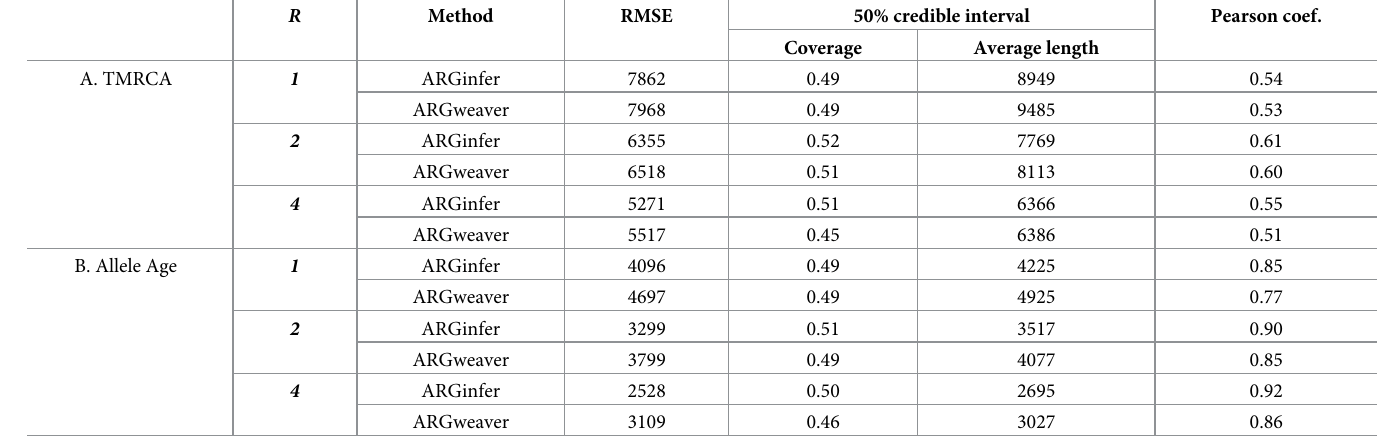
Table 3. The root mean square error (RMSE), coverage and average length of the posterior 50% equal-tailed intervals, for two ARG properties inferred by ARGinfer and ARGweaver . The ESS (reported in Table 2) is not available from ARGweaver for TMRCA and allele age, we report instead the Pearson correlation coefficient between posterior means and true